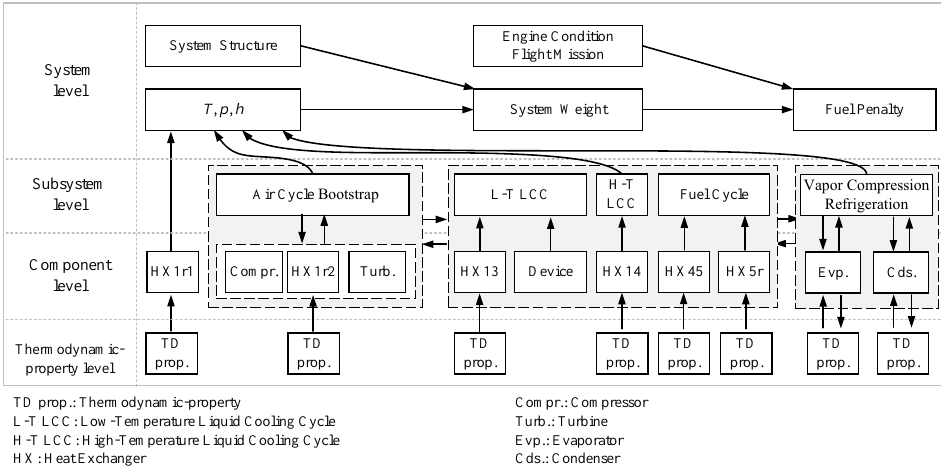
Figure 2. Levels of parameter matching of integrated thermal management